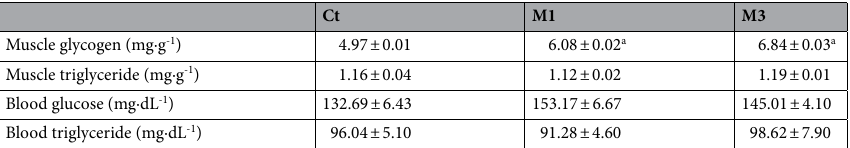
Table 1. Data on the muscle glycogen and triglyceride content and blood glucose and triglyceride concentrations in the groups that were treated with the vehicle (Ct) or melatonin (M1 and M3) and euthanized 1 (M1) or 3 (M3) hours after the last procedures. Control group (Ct); rats treated with melatonin and euthanized 1 h (M1) or 3 h after the last procedures (M3). Values are expressed as mean and standard error. a p < 0.05 with respect to Ct for the same parameter. g: grams; mg: milligrams; dL: